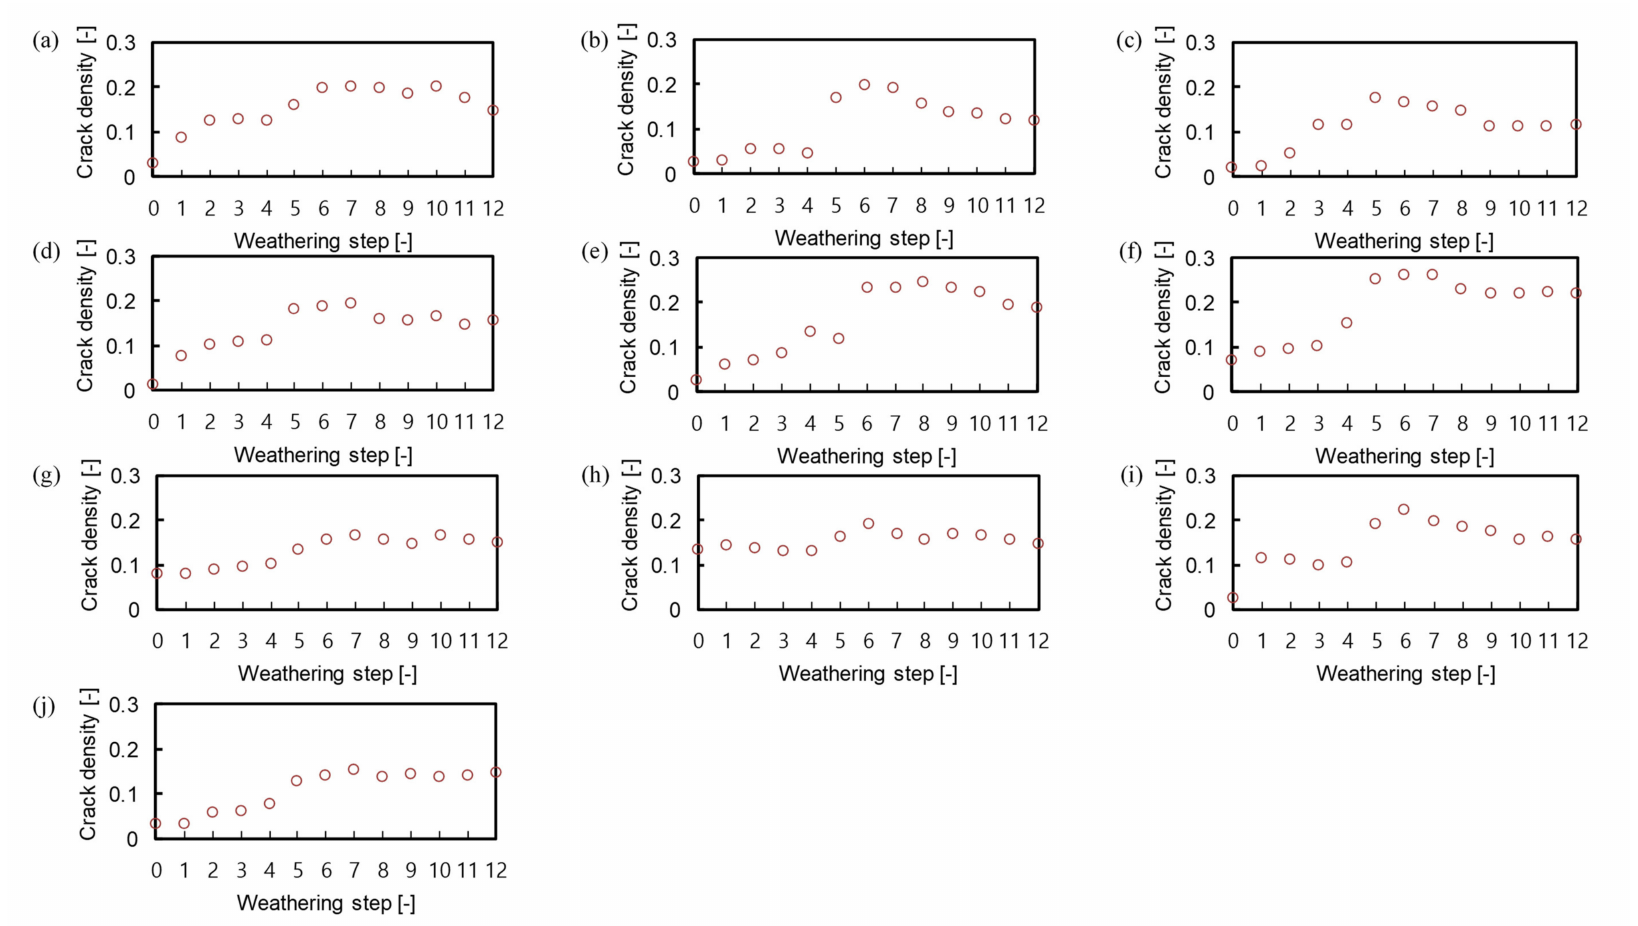
Figure 9. Distributions of crack density for each sample: ( a ) albite 1, ( b ) albite 2, ( c ) albite 3, ( d ) albite 4, ( e ) quartz 1, ( f ) quartz 2, ( g ) quartz 3, ( h ) biotite, ( i ) calcite, and ( j )